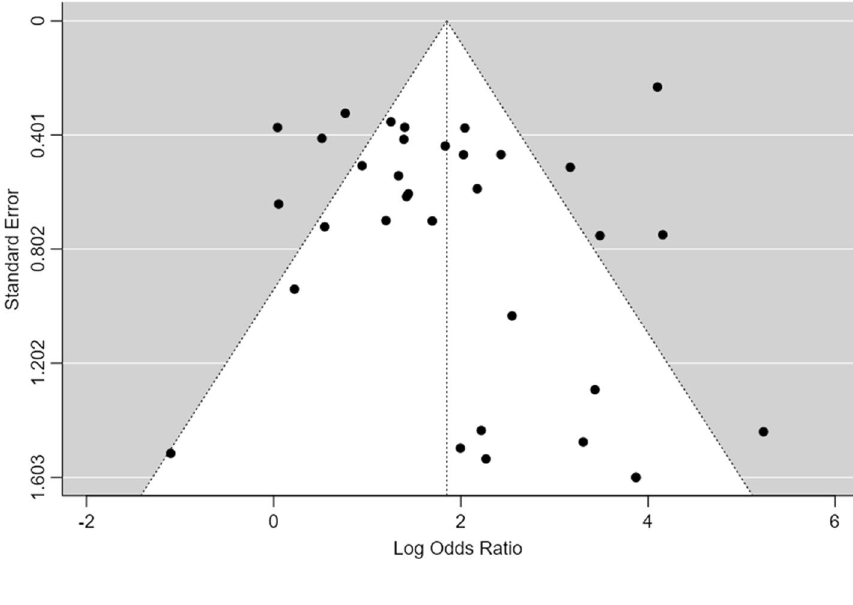
Fig. 3 Funnel-plot on the log(OR) of the included patient sets